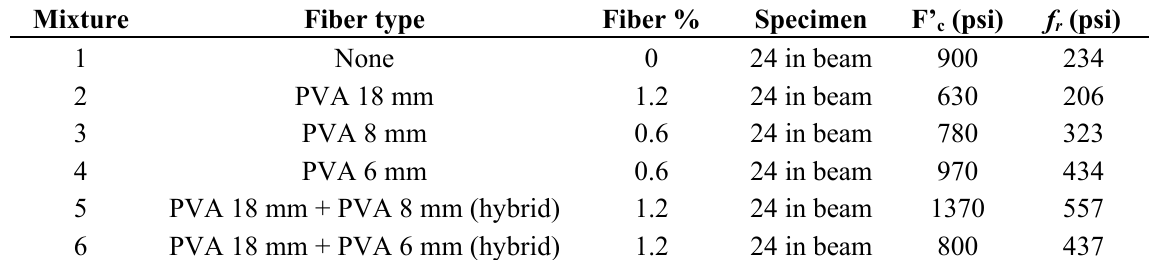
Table 1. Phase 1 test matrix and